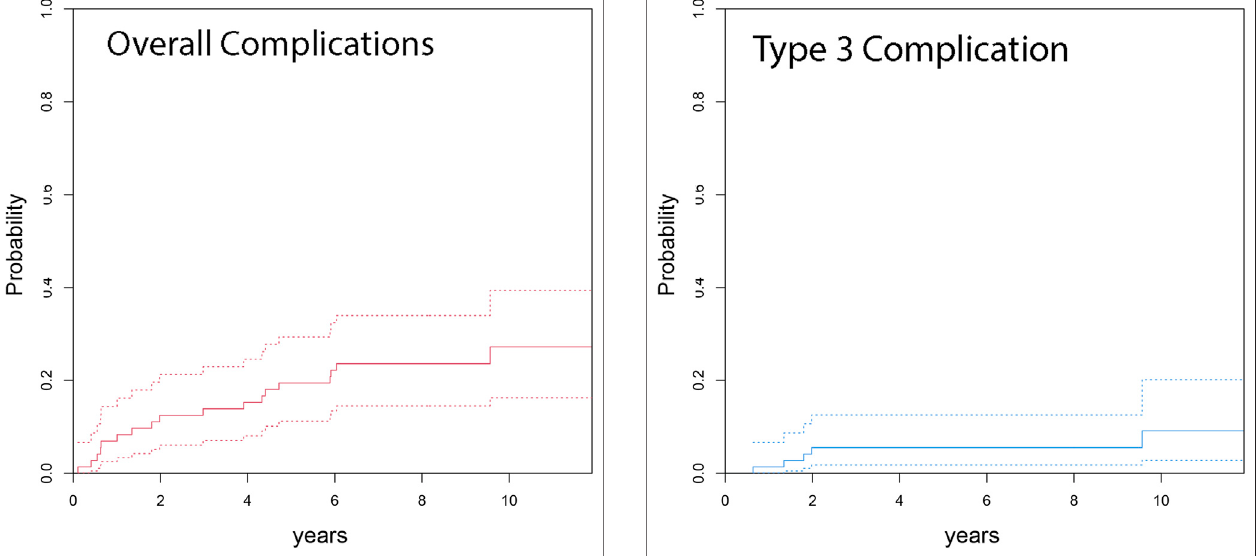
FIGURE 2 | Cumulative incidence from competing risk data for any type of complication was 13.9% at 3 years, 19.4% at 5 years, and 23.6% at 7 years after RH TKA (dashed lines indicate 95% CI).